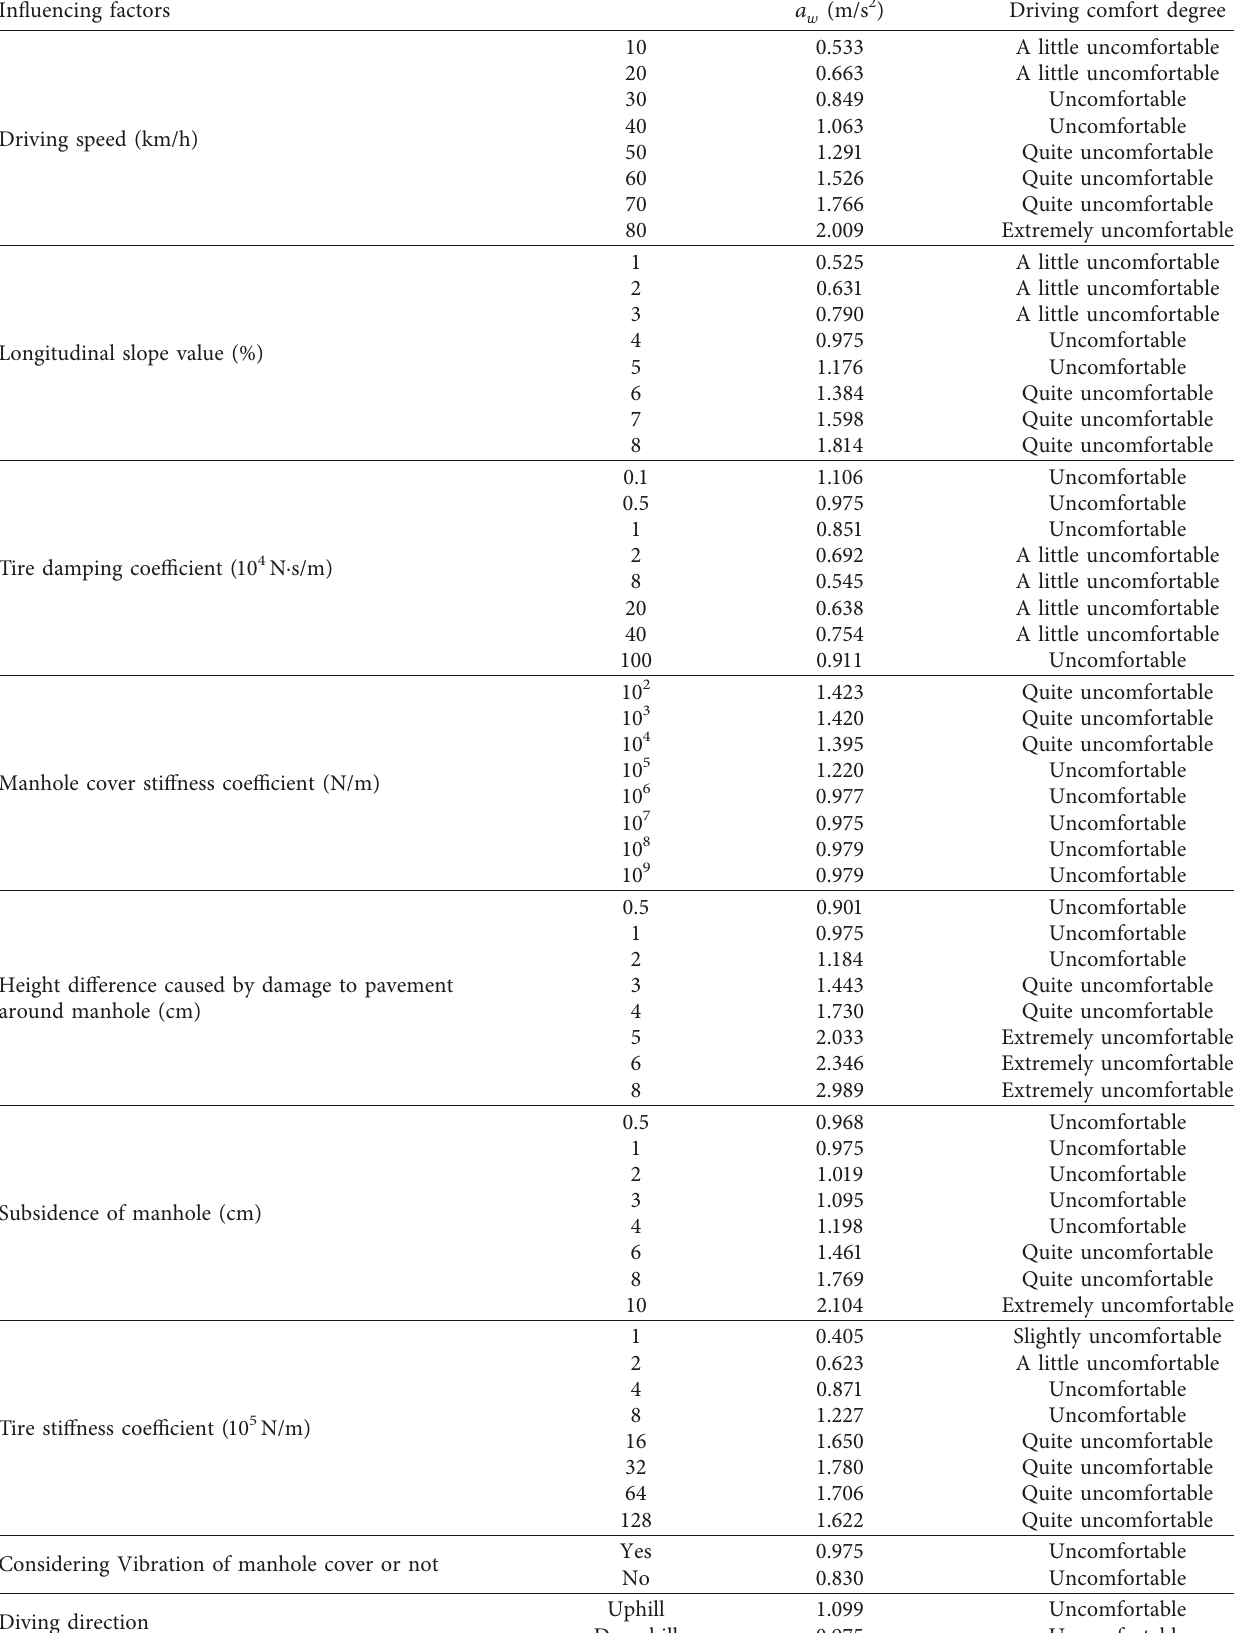
Table 3: Influencing factors and evaluation of driving